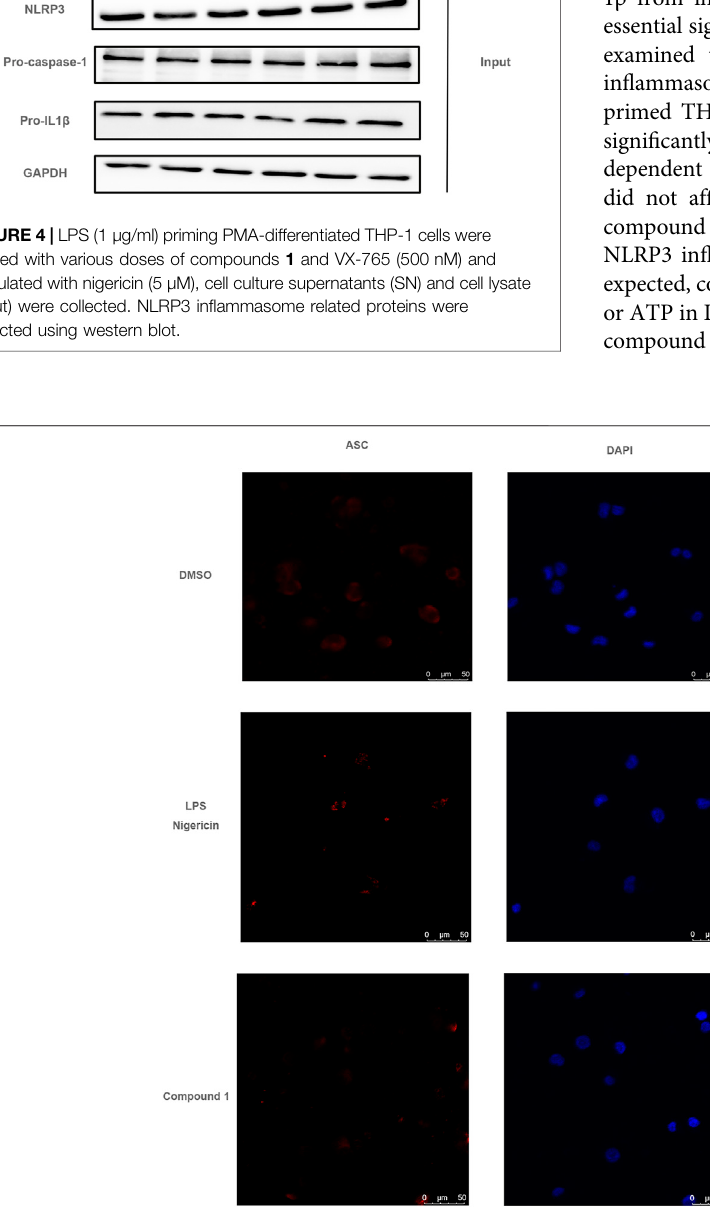
Frontiers in Pharmacology |